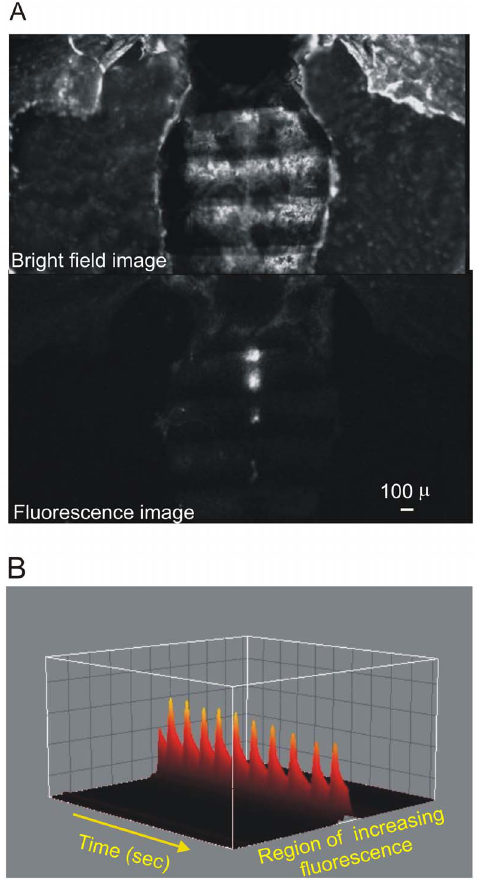
Figure 1. Visualization of fluorescence Ca 2 + signal in semi intact preparations. A. Top: Bright-field image of a fruit fly with heart exposed after removal of abdominal organs. Bottom: fluorescent signal of GCaMP3 protein that senses local increasing of Ca 2 + concentration. B. 3D representation of fluorescent peak recordings on the conical chamber–first abdominal segment - along